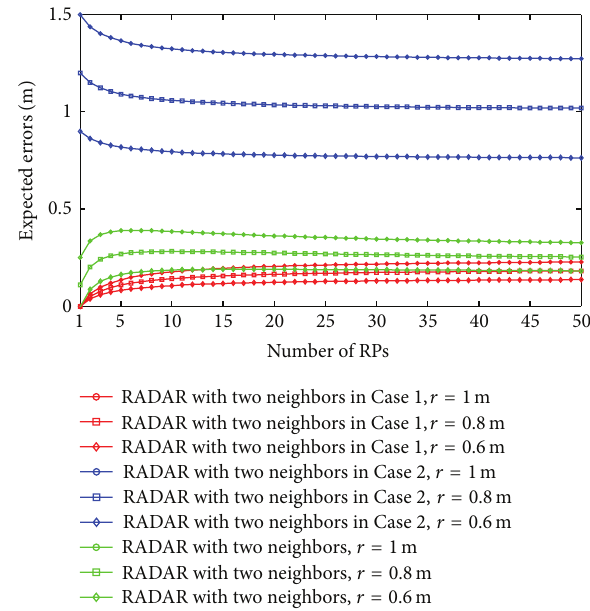
Figure 4: Expected errors by two-neighbor matching localization.